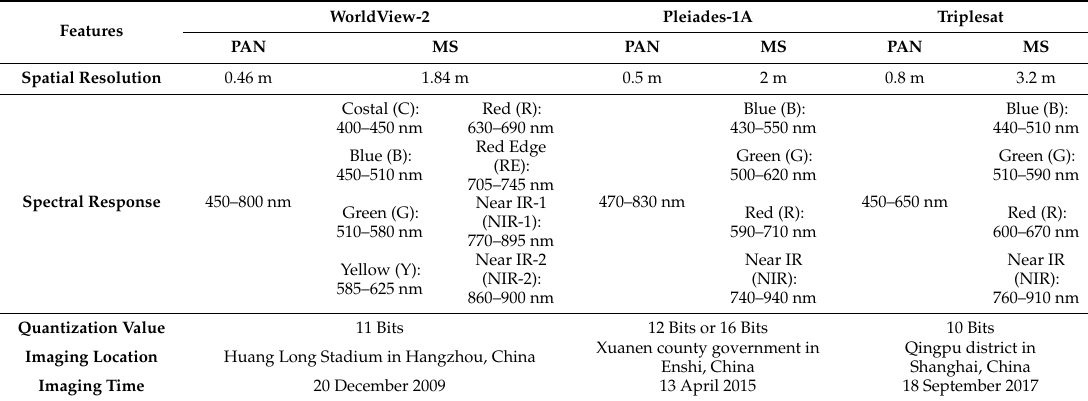
Table 1. Characteristics of three datasets used in this study.